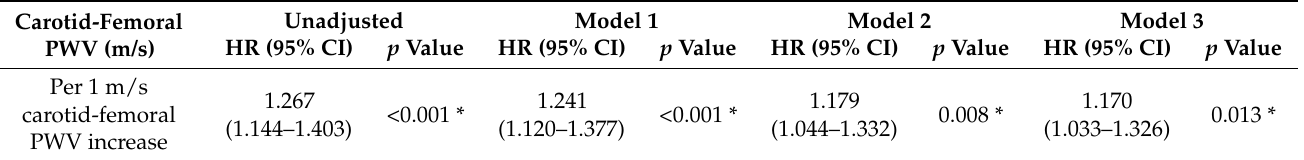
Table 3. Hazard ratio for all-cause mortality events by multivariable Cox regression of carotid-femoral pulse wave velocity levels among the 130 hemodialysis patients.